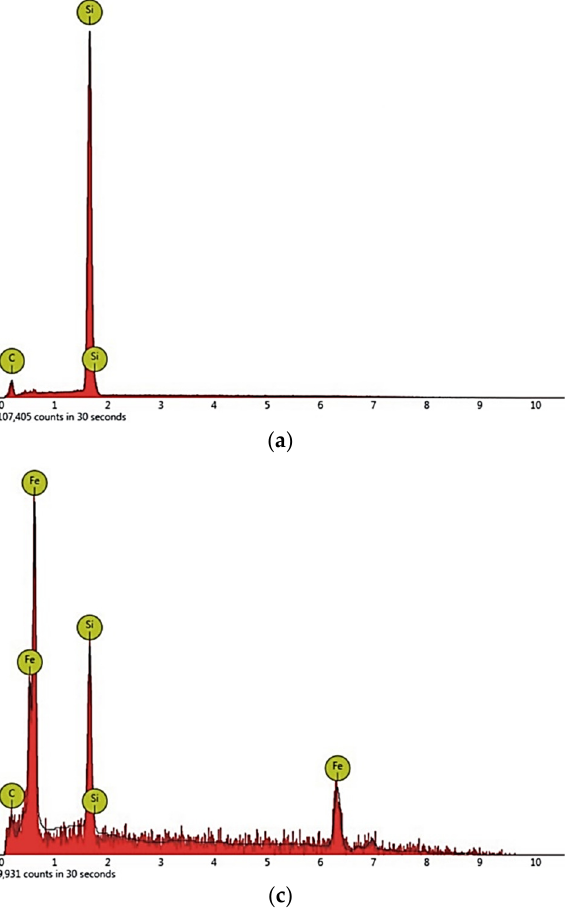
Figure 5. EDS point analysis spectrograms: ( a ) point 1 in Figure 4; ( b ) point 2 in Figure 4; ( c ) point 3 in Figure 4; ( d ) point 4 in Figure 4.